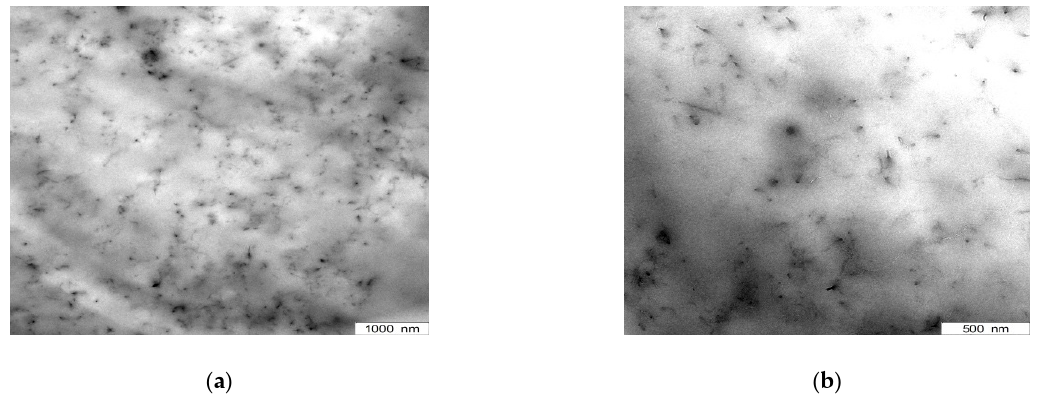
Figure 15. TEM images of PDMS/CNT-composites with CNTs oxidized using method “Ox 2” (( a , b ), two different scales).